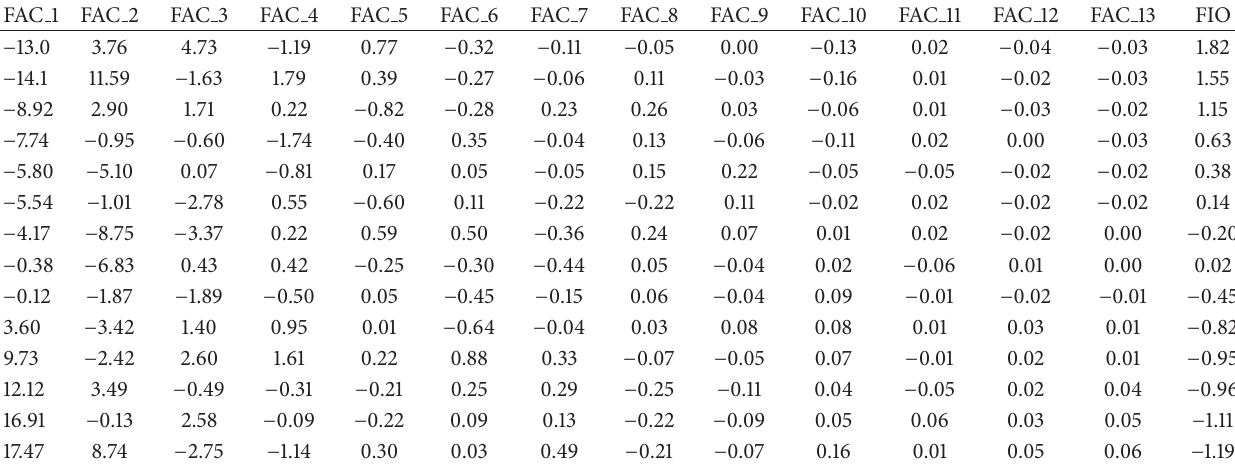
Table 6: The 13 principal components.